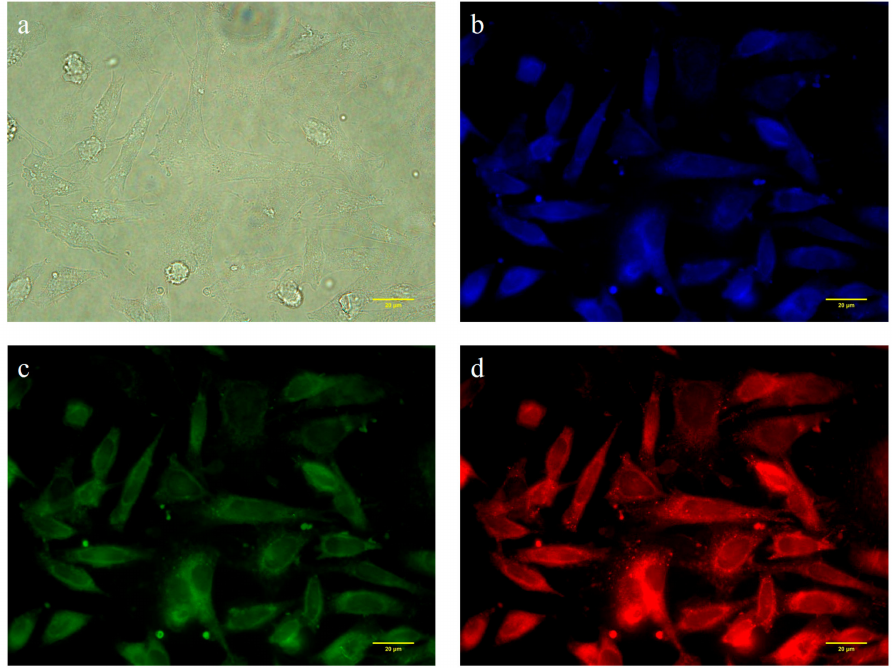
Figure 6. Fluorescence image of Tramp C1 cells staining with CDs: ( a ) The bright-field images and corresponding images under di ff erent fluorescence channel; ( b ) DAPI channel: Ex: 350–400 nm, Em: 420–470 nm, DC: Without setting; ( c ) WB channel: Ex: 460–490 nm, Em: 520 nm long pass, DC: 500 nm and ( d ) WG channel: Ex: 510–550nm, Em: 590 nm long pass, DC: 570 nm. Scale bar = 20 µ